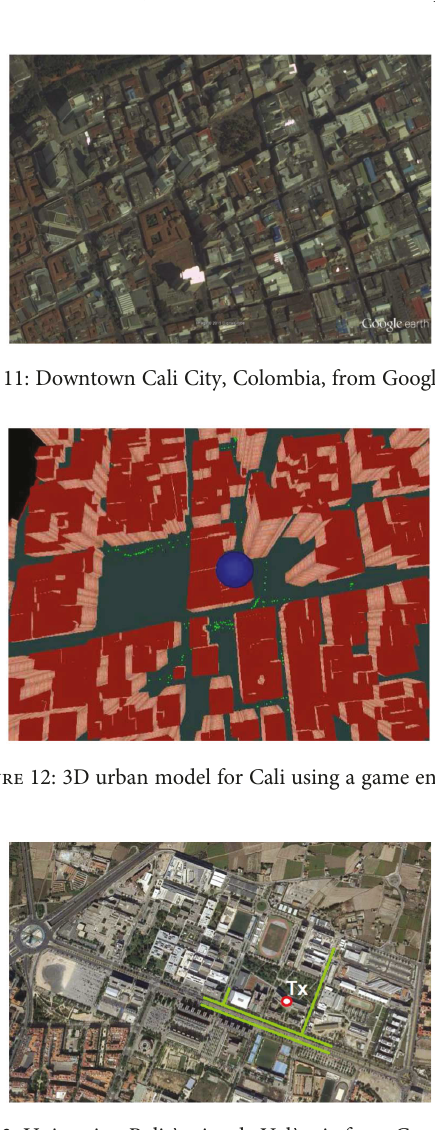
Figure 13: Universitat Politècnica de València from Google